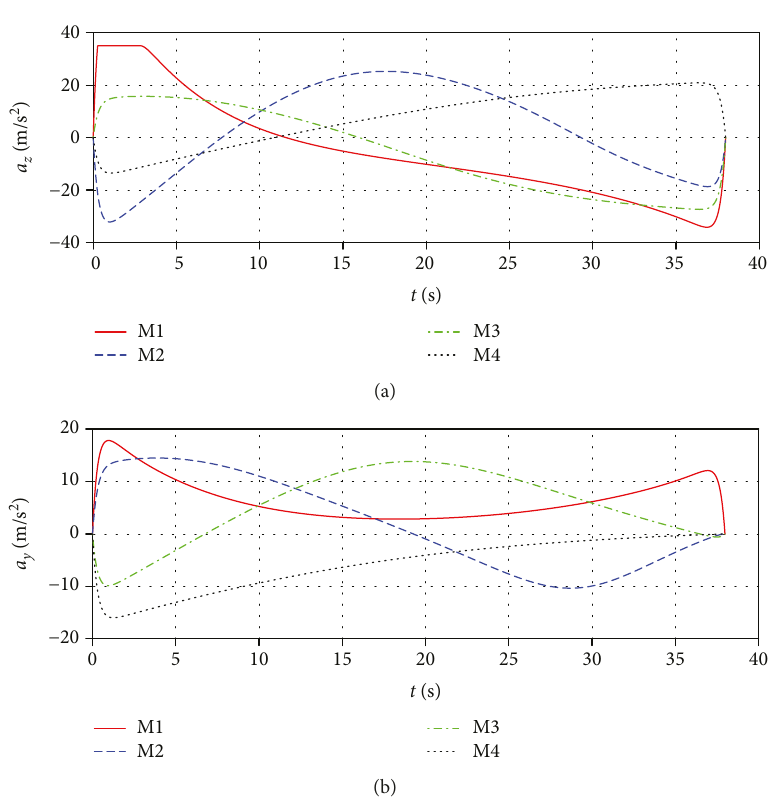
Figure 15: Limited missile acceleration with impact time and angle control.